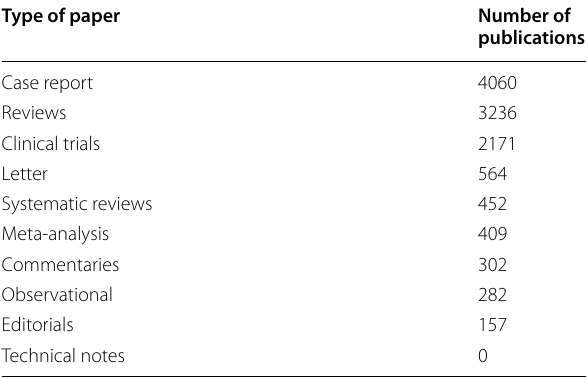
Table 5 Number of cancer-related publications in Arab countries according to the type of